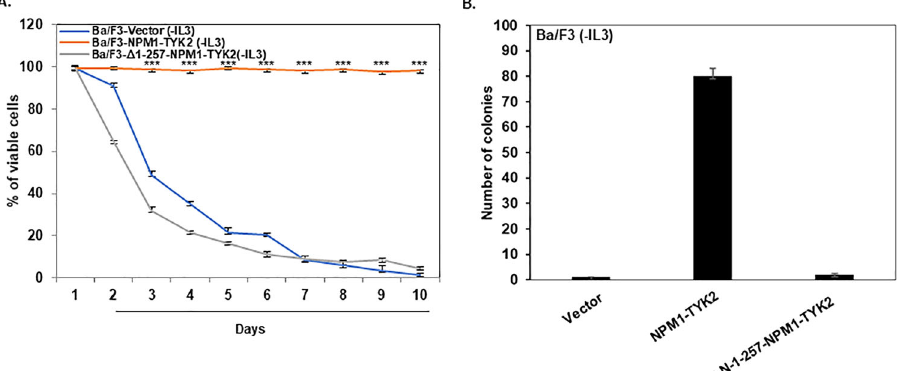
Fig. 8 Loss of NPM1 partner abrogates NPM1 – TYK2 transformation potential. A Deletion of NPM1 portion in NPM1 – TYK2 fusion gene abrogates the transformation potential of the NPM1 – TYK2 fusion gene in Ba/F3 cells. Ba/F3 cells were transduced with lentiviral particles expressing vector, NPM1 – TYK2, and Δ N-1 – 257-NPM1 – TYK2. Cells were grown in RPMI medium without IL-3 growth factor for 10 days. Cell viability from each condition was determined daily by trypan blue exclusion assay. Points represent the mean of three independent experiments; bars represent SEM. ∗∗∗ P < 0.0005 was considered as statistically extremely signi fi cant. B The deletion of the NPM1 portion in the NPM1 – TYK2 fusion gene inhibits the clonogenic potential. Columns represent the mean of three independent experiments; bars represent the SEM.